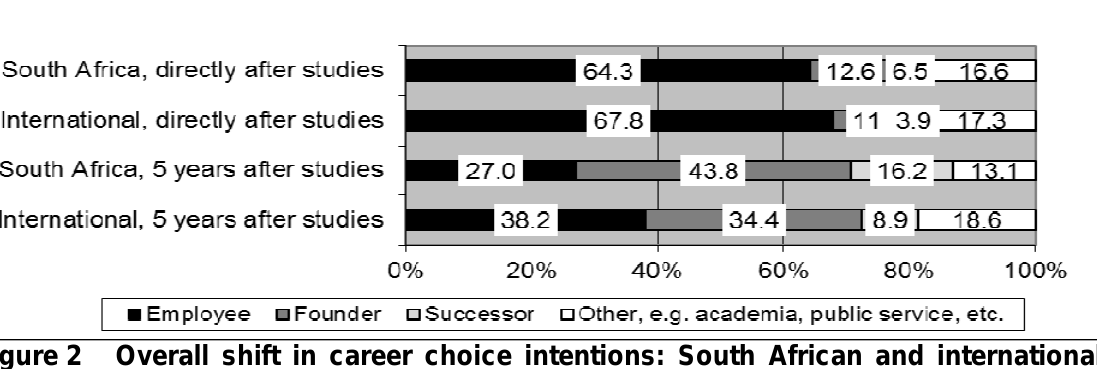
Figure 2 Overall shift in career choice intentions: South African and international students